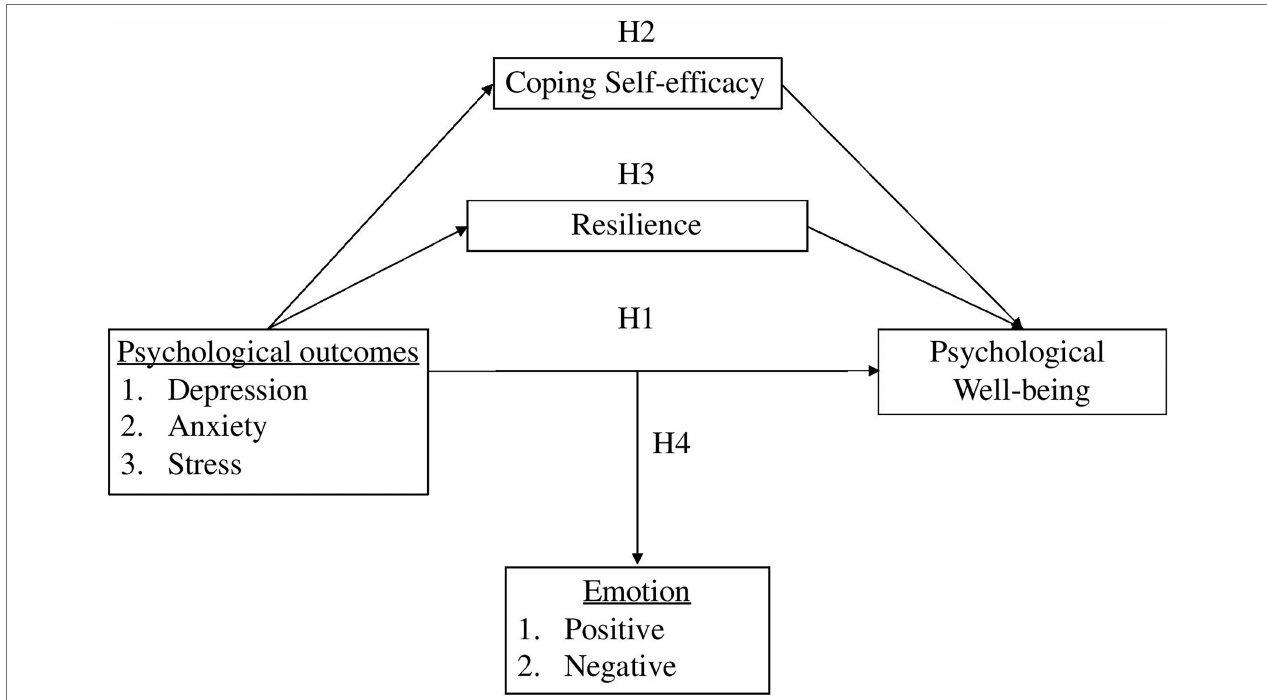
FIGURE 1 | The conceptional framework of the mediation-moderation model. Note: independent variable (IV): depression, anxiety, stress; dependent variable (DV): psychological wellbeing; mediator: resilience, coping self-efficacy; moderator: Positive emotion.